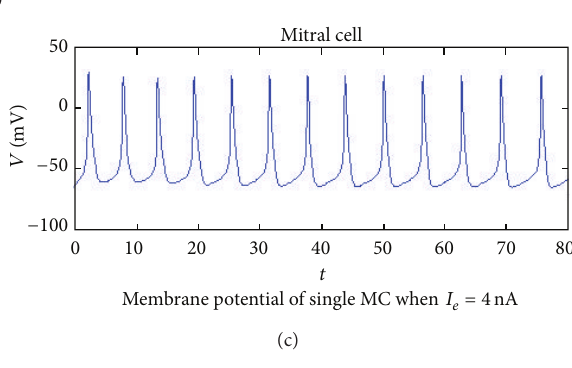
Figure 2: Spike trains of a MC under different stimulus.